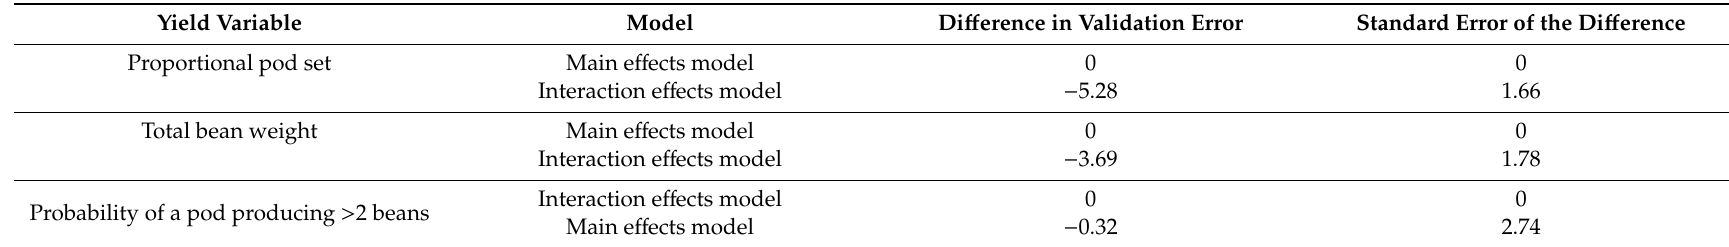
Table 5. The di ff erence in predictive accuracy between the Main e ff ects model (Heat and Insecticide + random e ff ects) and the model including the interaction (Heat × Insecticide + random e ff ects) on yield parameters. The model with the highest predictive accuracy is ranked as 0 with values showing the di ff erence in validation error and standard error of the di ff erence between models.